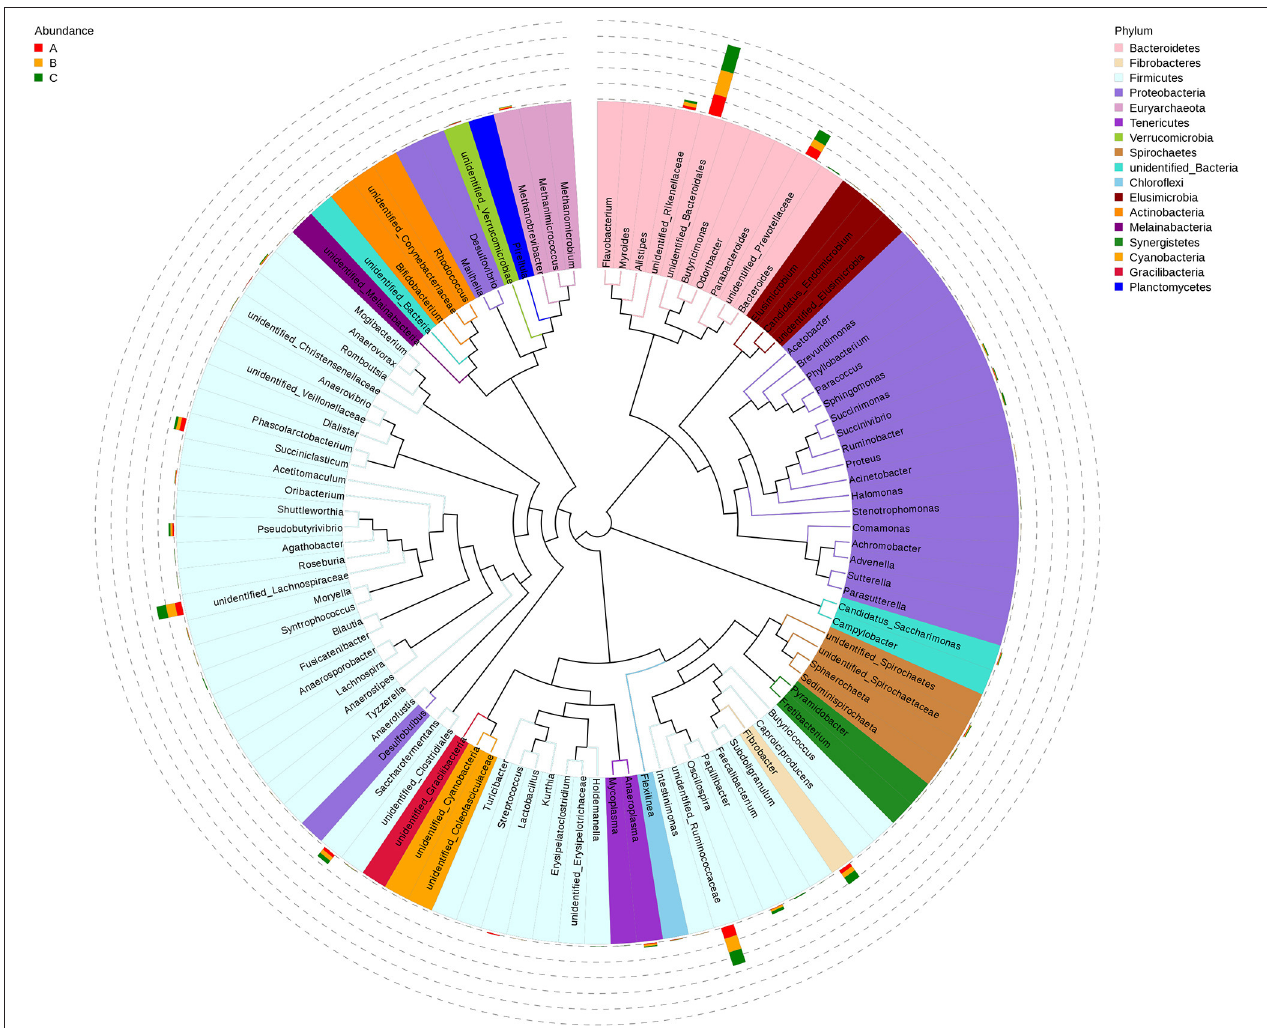
FIGURE 2 | Phylogenetic tree of genus level species among PSR silage totally or partially substituted the corn silage groups in Angus beef cattle ( N = 5). Group A, fed 60% PSR silage; Group B, fed 30% PSR silage + 30% corn silage; and Group C, fed 60% corn silage. Branches and fan colors represent its corresponding phyla, the accumulation histogram outside the fan ring shows the relative abundance distribution information of the genus in different